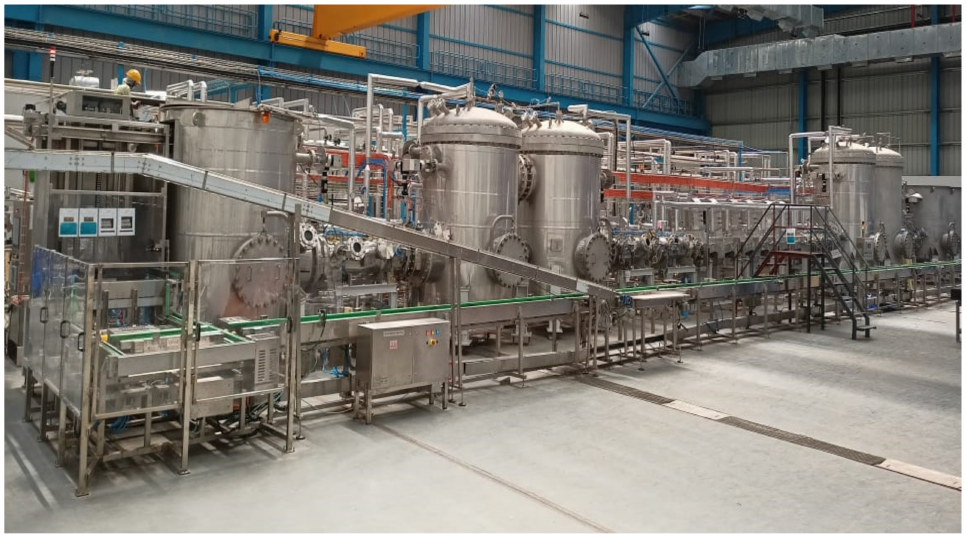
Figure 1. A continuous 915 MHz MATS system for production of shelf-stable meals (courtesy of 915